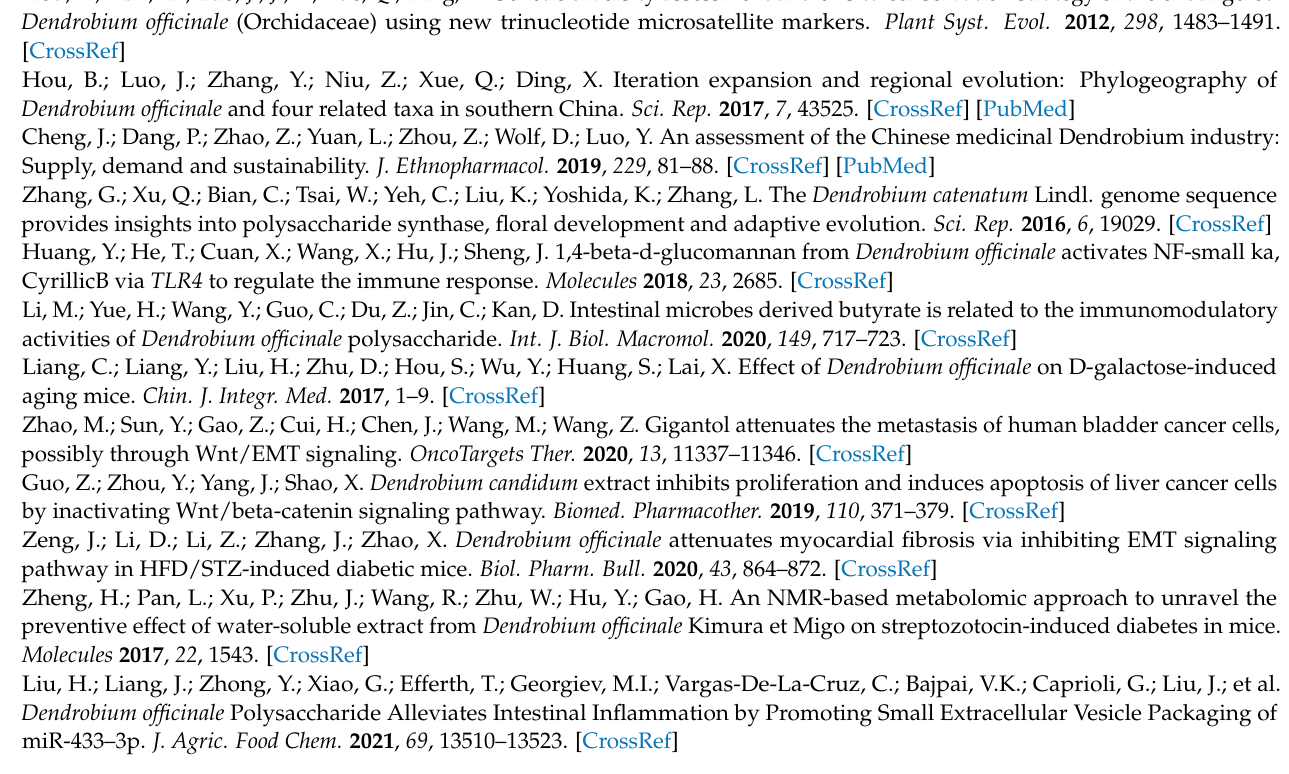
modules. Table S1: The full information about the correlation the co-expressed gene modules and metabolites were listed. Table S2: Differential expression of TFs in light- and K-treated D. officinale. Table S3: The treatment-altered pattern and annotation of metabolites or DEGs in light- or K-treated D. officinale. Table S4: The treatment-altered pattern and annotation of metabolites or TFs in light- and K-treated D. officinale. Table S5: RT-qPCR primers of D. officinale genes. Table S6: The FPKM matrix of 14, 465 D. officinale genes transcripts across nine RNAseq